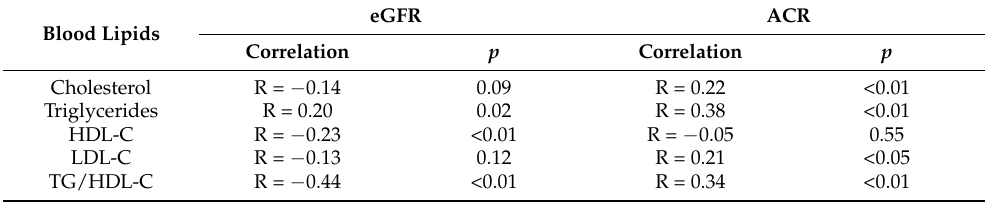
Table 4. Correlation of blood lipids and TG/HDL-C with eGFR and